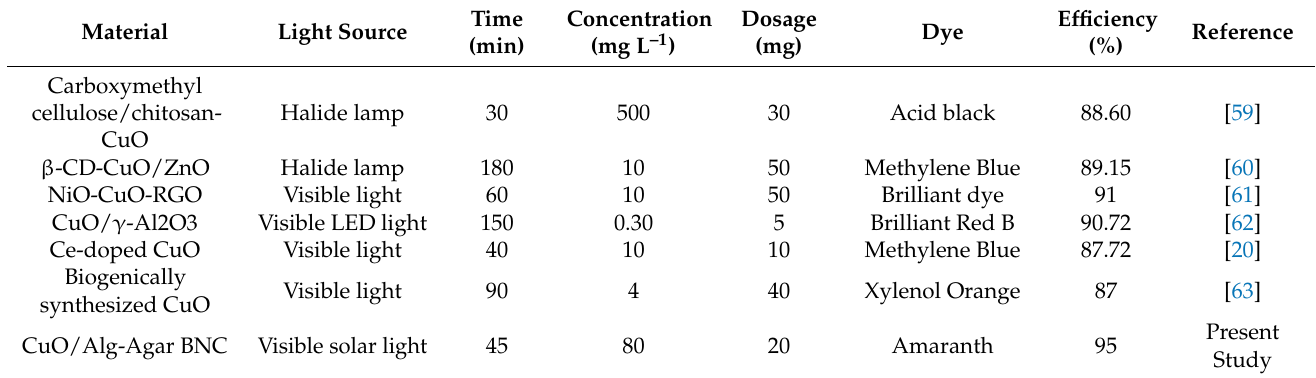
Table 5. Comparison of present study with